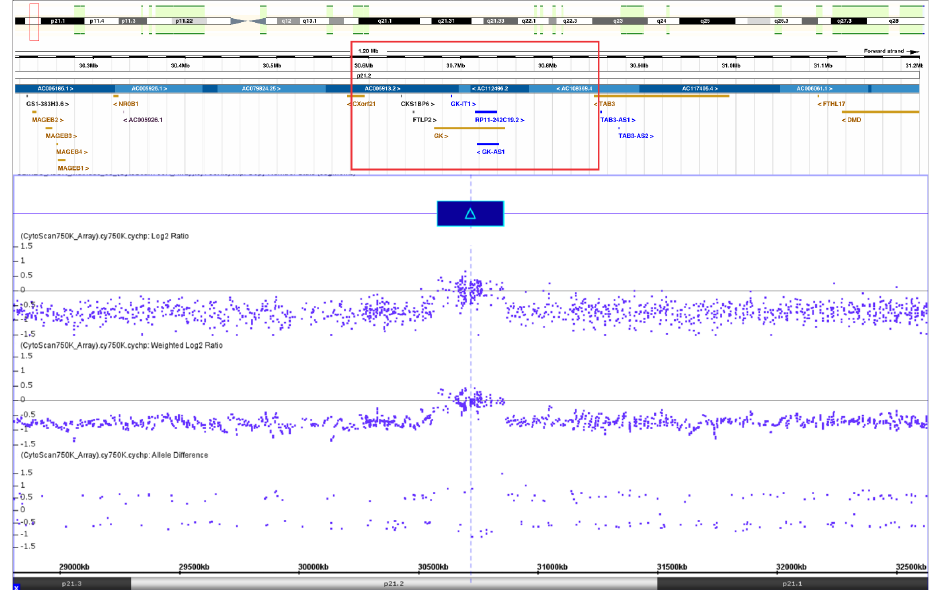
Figure 1. Chromosome microarray analysis showing duplication of approximately 277kb at Xp21.2 not covering the NR0B1 gene.